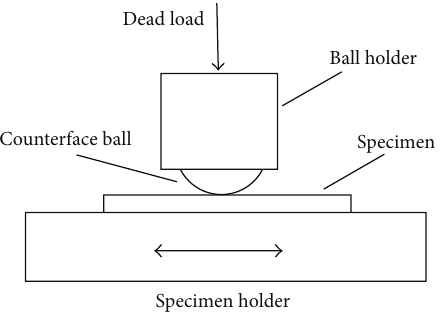
Figure 1: Diagrammatic sketch of the friction couple